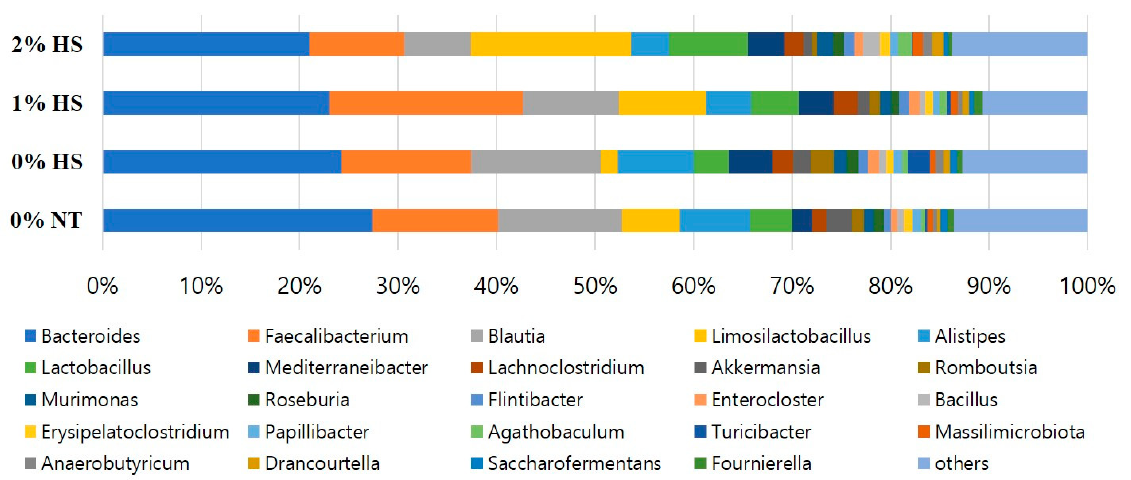
Figure 8. Effects of dietary steam-exploded pine particles supplementation and subsequent heat stress on the composition of cecum microflora of chicken at the genus level. Data represent the top 24 abundant microflorae. The treatments were control diet containing 0% steam-exploded pine particles (SPP) at thermoneutral temperature (0% NT), control diet with acute heat stress (0% HS), 1% SPP-supplemented diet at acute heat stress (1% HS), and 2% SPP-supplemented diet at acute heat stress (2% HS). The thermoneutral birds were maintained at 21.0 °C while the temperature of the heat-stressed room was raised to 31 °C within the first three hours and then maintained for another three hours that makes the total HS period of six hours.